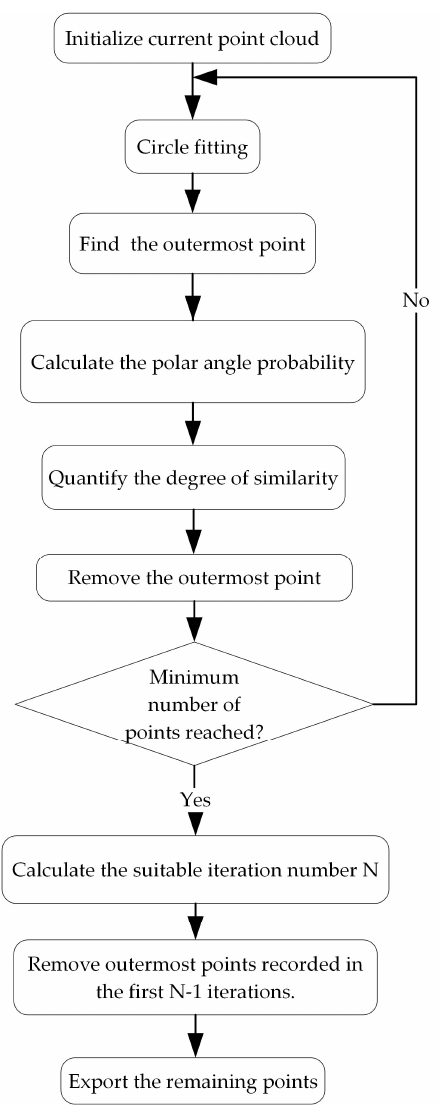
Figure 8. The flowchart of